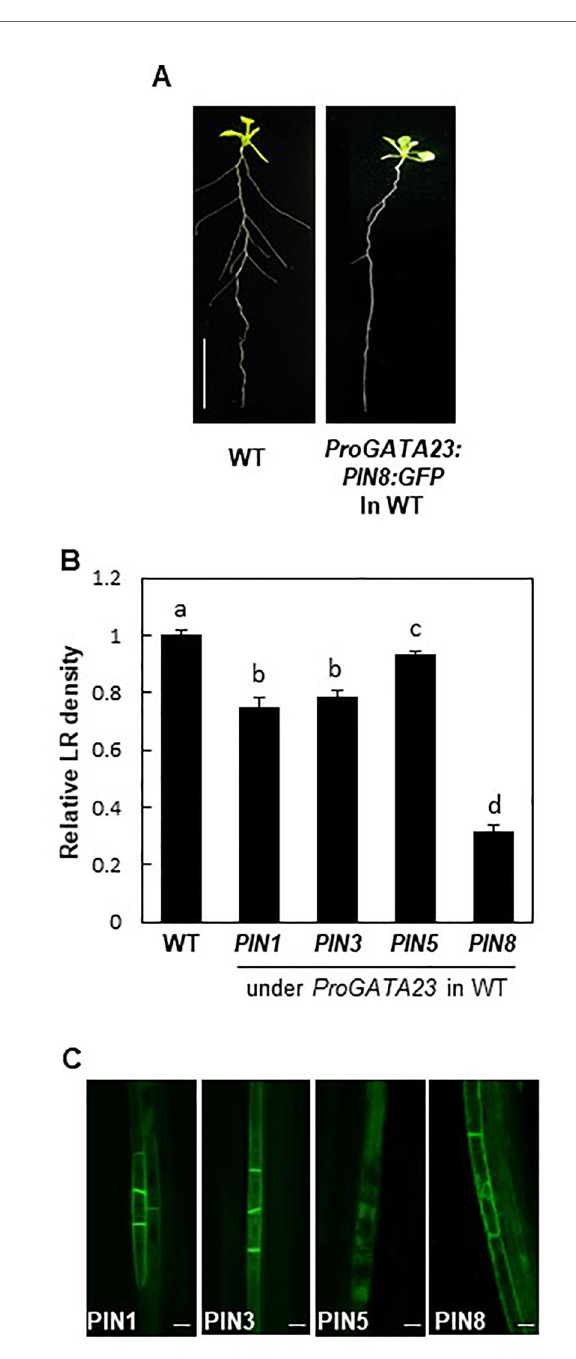
FIGURE 5 | Effect of PINs on lateral root (LR) development when expressed in the GATA23 domain. (A) Root phenotypes of the wild type (WT) and ProGATA23:PIN8:GFP transgenic line. (B) LR densities of the WT and ProGATA23:PINs : GFP transgenic lines. Data represent mean ± SE [ n = 89 – 694 seedlings; in case of transgenics, 3 – 12 independent lines per construct were observed ( Supplementary Figure S7G )]. Statistically signi fi cant differences are denoted with different letters [ P < 0.05; one-way ANOVA with Tukey's unequal N honest signi fi cant difference (HSD) post hoc test]. (C) Confocal images of pericycle cells expressing PIN : GFP fusions under the control of ProGATA23 . Scale bar = 20 µm.